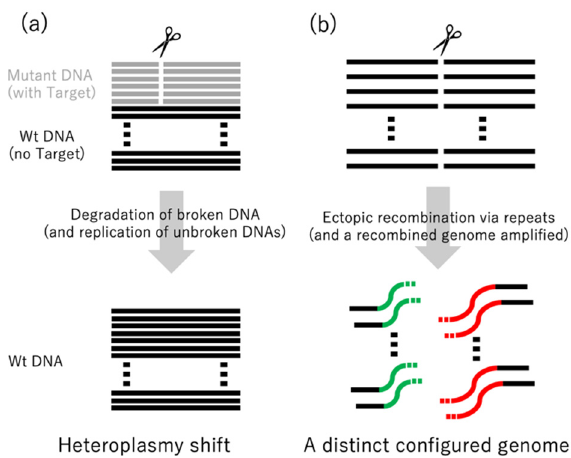
Figure 3. Comparison of the effects of mitoTALENs in mammalian and plant mitochondria. In mammals ( a ), mitoTALENs create DSBs at different sites of mutation, resulting in selective elimination of the mutant DNAs (resulting in a shift from heteroplasmy to homoplasmy). In plants ( b ), all copies of the specific sites are cut, resulting in different conformations of the genome by recombinations between repeats near and far from the target sites.